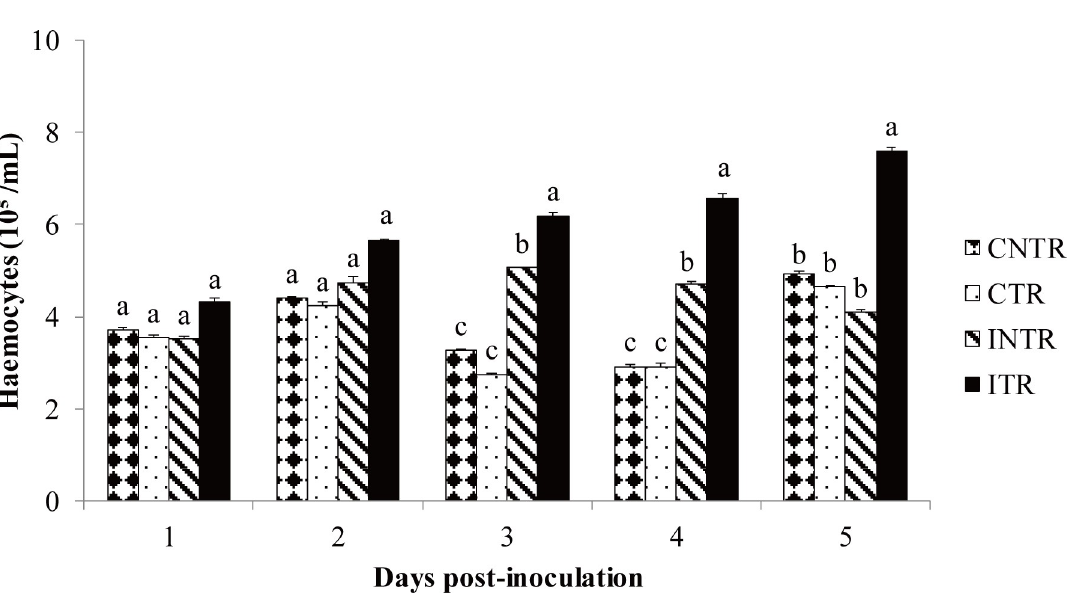
Fig 7. Total haemocyte count. Mean haemocyte concentrations in haemolymph samples of Locusta migratoria manilensis inoculated with Beauveria bassiana (3 × 10 5 spores/5 th instar nymph) at different days post-infection. CNTR, control non-thermoregulating insects; CTR, control thermoregulating insects; INTR, infected non-thermoregulating insects; ITR, infected thermoregulating insects. Data are given as concentration (means ± SE). 10–15 insects were infected per treatment and per interval. Different letters indicate significant